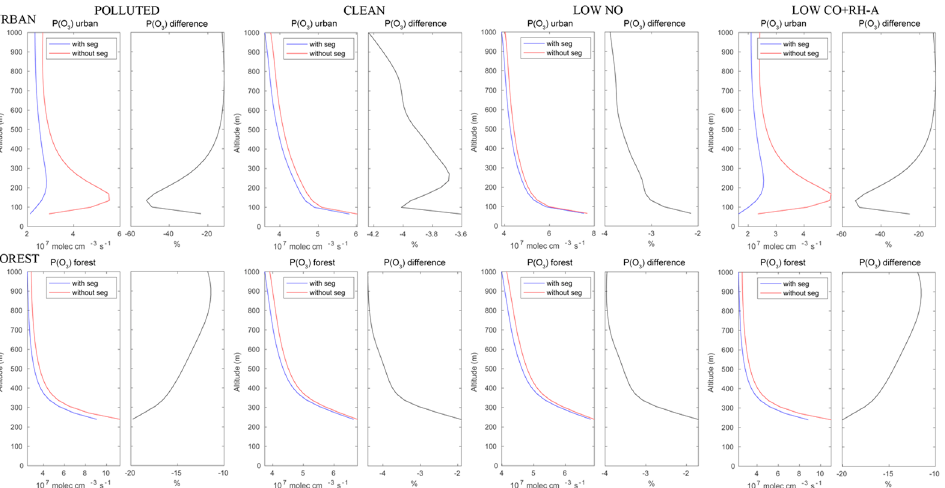
Figure 6. Upper panels: production rate of ozone in the urban area with and without segregation. Lower panels: same but for the forested areas. First columns: polluted conditions; second columns: clean conditions; third columns: low NO conditions; fourth columns: low CO+RH-A conditions. The relative difference is a measure of the effect of